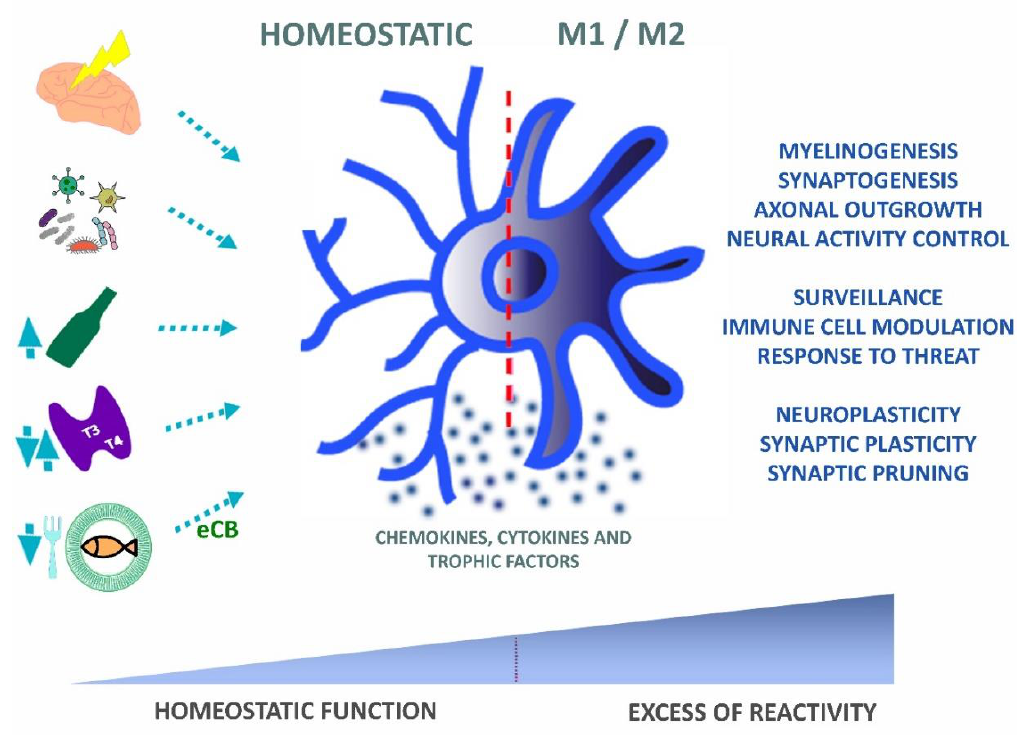
Figure 3. Microglial functional balance is affected by a diversity of environmental factors. Under physiological conditions, microglia interact with the microenvironment through multiple factors (chemokines, cytokines, or/and trophic factors) which modulate its functions in health and disease. As it receives multiple signals from the environment (e.g., brain trauma or injury, infection, alcohol, hormonal imbalance, or omega-3 fatty acid (FA) dietary restrictions), these cells undergo dynamic phenotypic modifications, which convert the homeostatic microglia into reactive microglia. Endocannabinoids derived from the diet act as anti-inflammatory signaling molecules that may restore microglial homeostatic functions. The phenotypic shift towards pro- and anti-inflammatory phenotypes can result in a healing process, whereas an excess of pro- over anti-inflammatory activation can result in pathological outcomes. Normal synaptic pruning and developmental circuitry remodeling depends on homeostatic microglia and, thus, an excess activation through environmental stressors may result in a loss of microglial physiological functions with possible implications on the emergence of pathological conditions such as autism and schizophrenia.